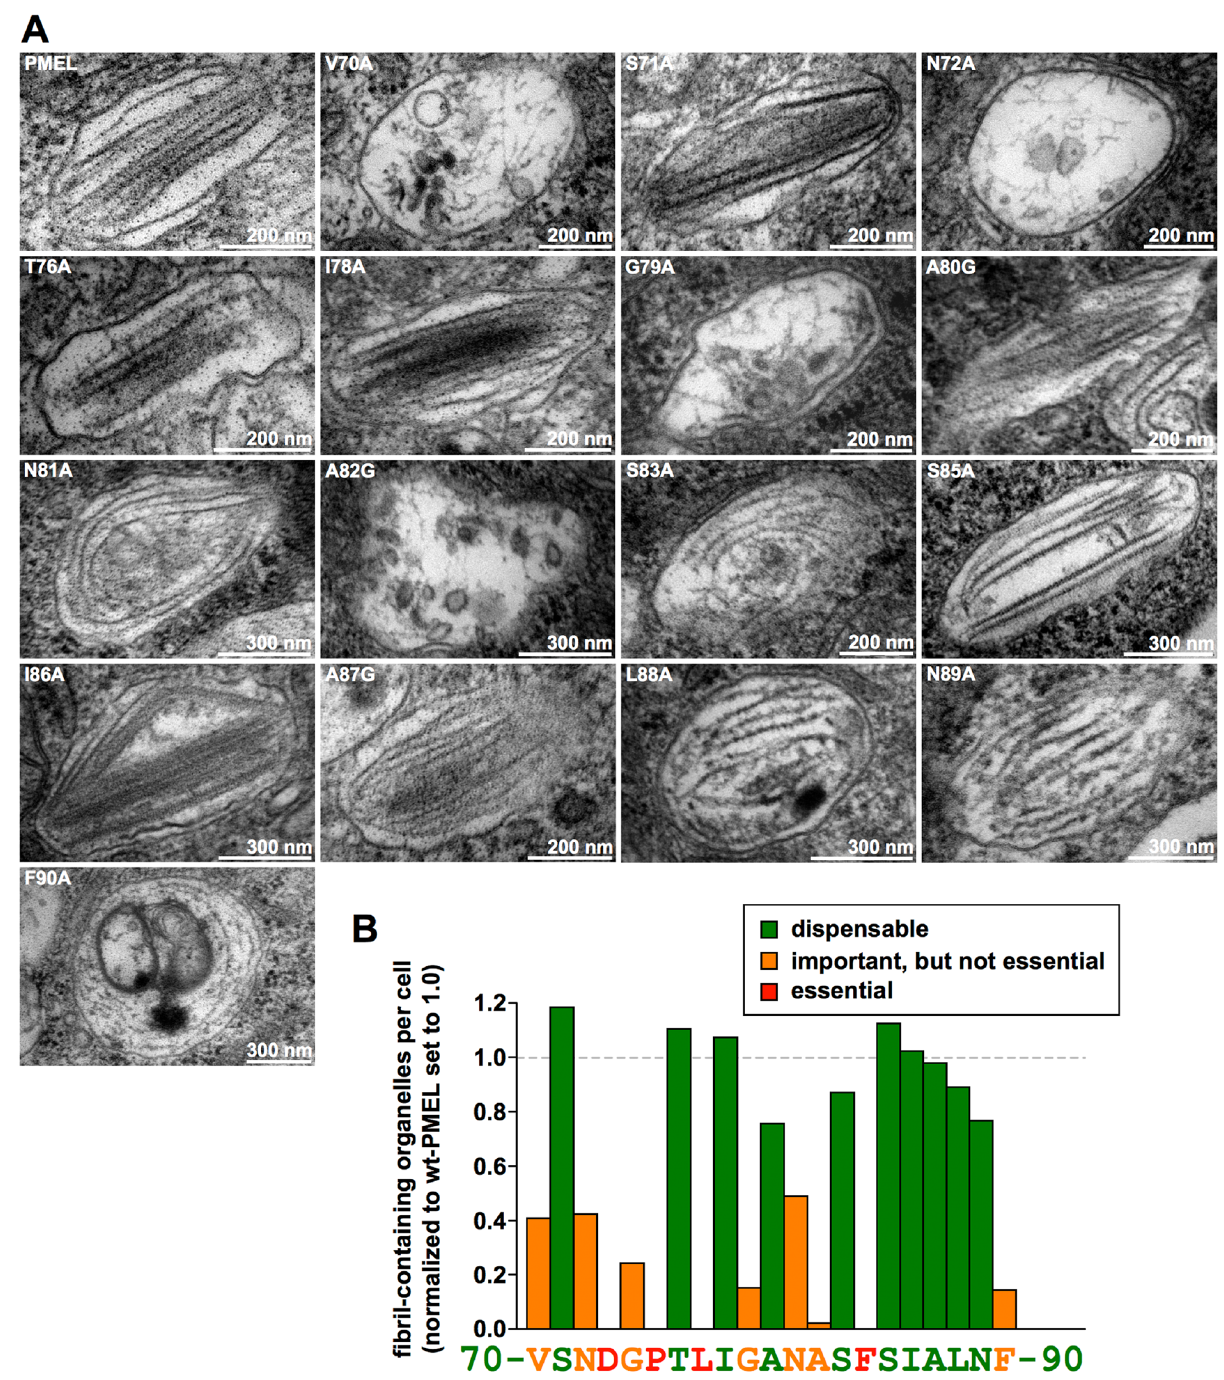
Figure 4. Melanosomal amyloid formation by PMEL alanine-scanning mutants. ( A ) EM analysis of Epon- embedded stable Mel220 transfectants expressing PMEL alanine-scanning mutants. Melanosomes of mutants that form fibrils are shown. The respective quantification of fibril formation in the indicated cell lines is depicted in Suppl. Fig. S4 B–E and summarized in ( B ). ( B ) Quantitative EM analysis of PMEL alanine-scanning mutants. Shown is the number of fibril-containing organelles per cell [N = 15] after normalization to wt-PMEL (set to 1)). Essential (category 3), relevant (category 2), and largely dispensable residues (category 1) are colored in red, orange, and green,